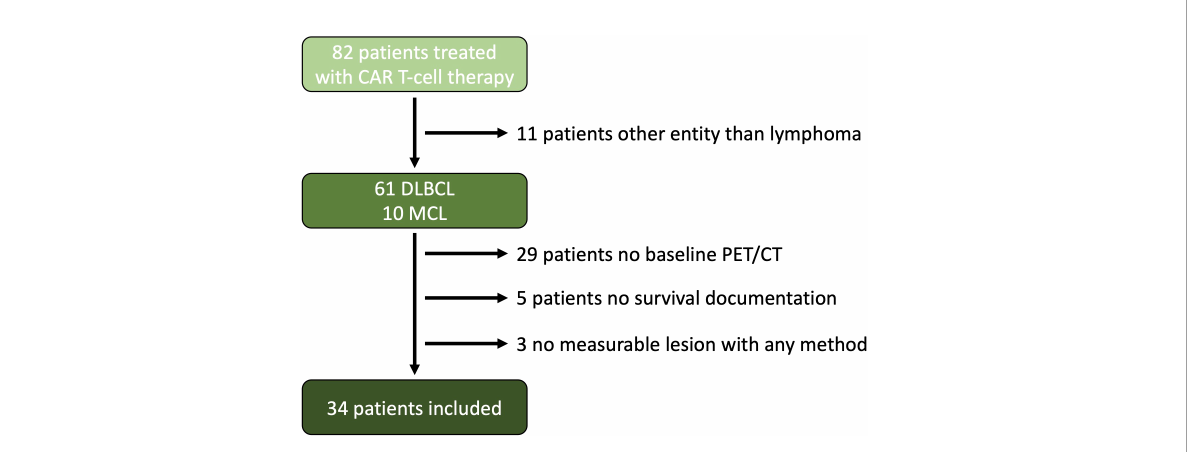
FIGURE 1 Flow Chart. A total of 82 patients were treated with CAR T-cell therapy at our site starting from Jan. 2019 to Feb. 2022. 11 patients were excluded because of entities other than lymphoma, 29 patients did not have a baseline PET/CT examination near before CAR T-cell transfusion, and 5 patients were excluded because of lack of survival documentation, and 3 patients did not have a measurable lesion according to the Lugano criteria or a hypermetabolic